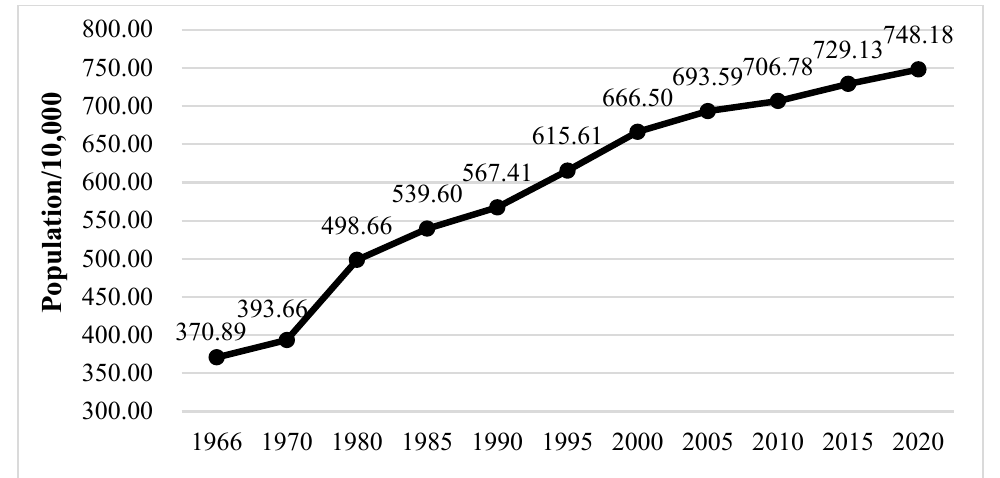
Figure 6. Line chart of Hong Kong’s GDP, 1966–2020 (Source: World Bank, IMF).